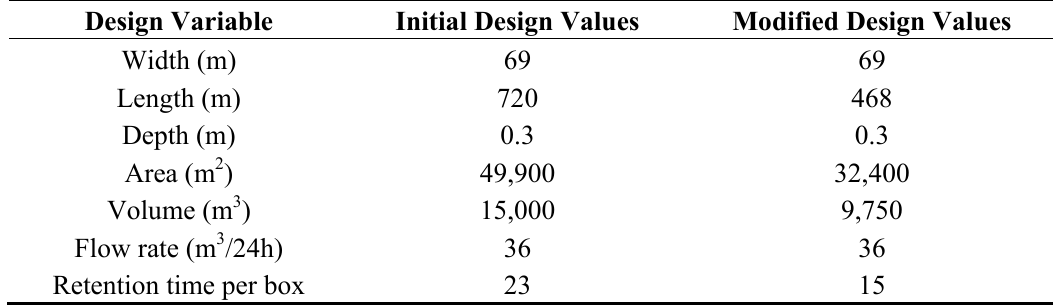
Table 5. SubWet design values for the Chesterfield Inlet tundra wetland as they currently exist (Initial) and the modified design values if the wetland were to be reduced in size by 35%.